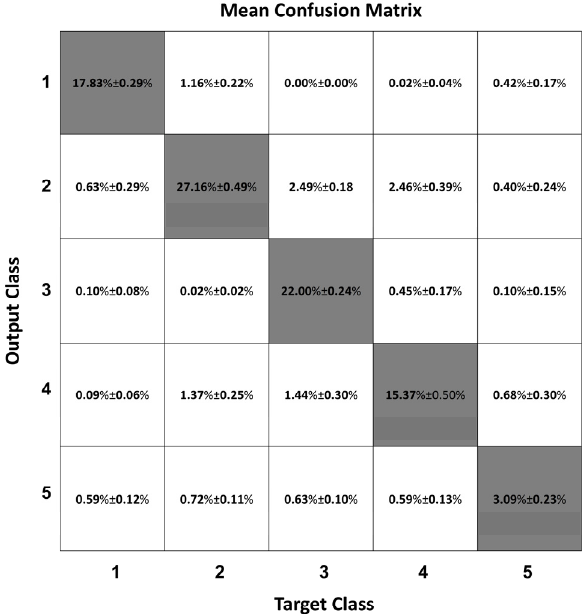
Figure 10. Mean confusion matrix obtained from the 30 simulations of the 2BLSTM2D network.